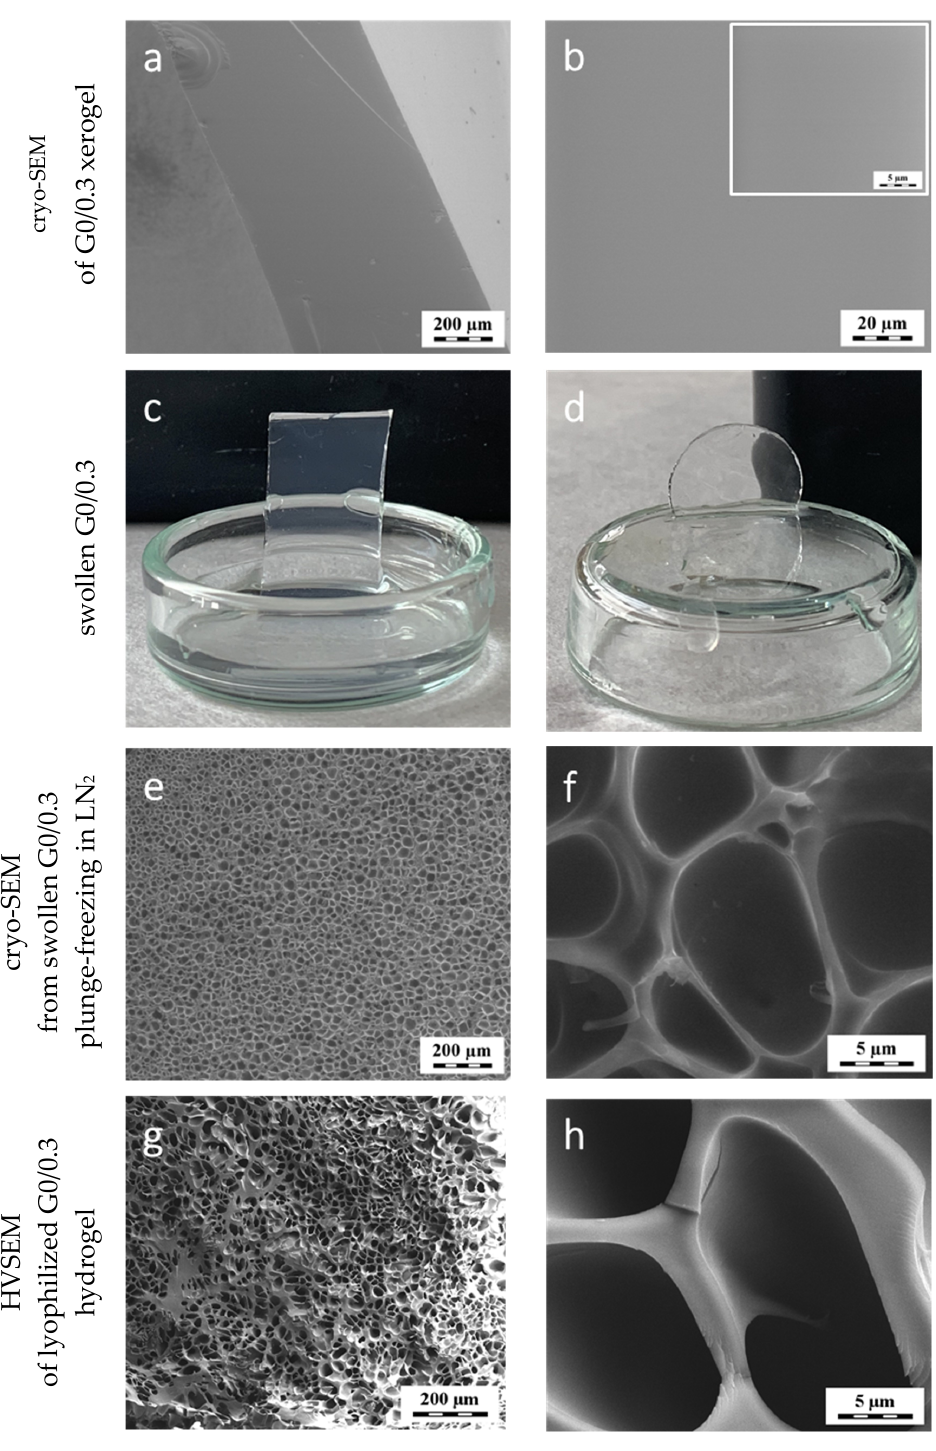
Figure 1. Appearance of the G0/0.3 sample at different stages: ( a , b ) G0/0.3 xerogel observed in the dry state as obtained by bulk polymerization; ( c , d ) photographs of the equilibrium water- and DMSO-swollen G0 / 0.3 hydrogel, respectively, ( e , f ) cryo-SEM from the water-swollen sample and ( g , h ) high vacuum scanning electron microscopies (HVSEM) of the lyophilized